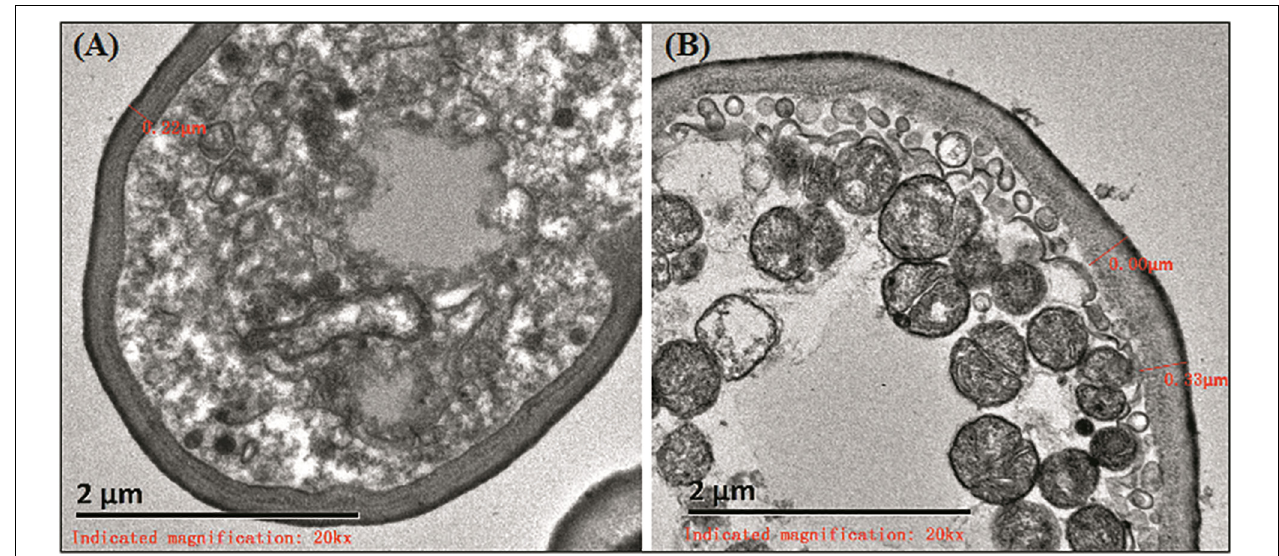
FIGURE 1 | Ultrastructure of biofilms. (A) The cell wall of strain that did not form biofilms was about 220 nm. (B) The biofilm formation strains were rich in mitochondria.